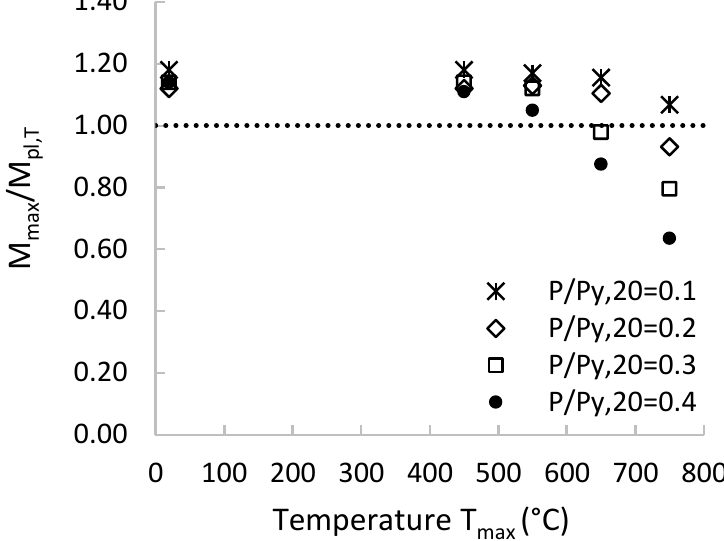
Figure 16. Overstrength factor considering the degradation of yield strength.